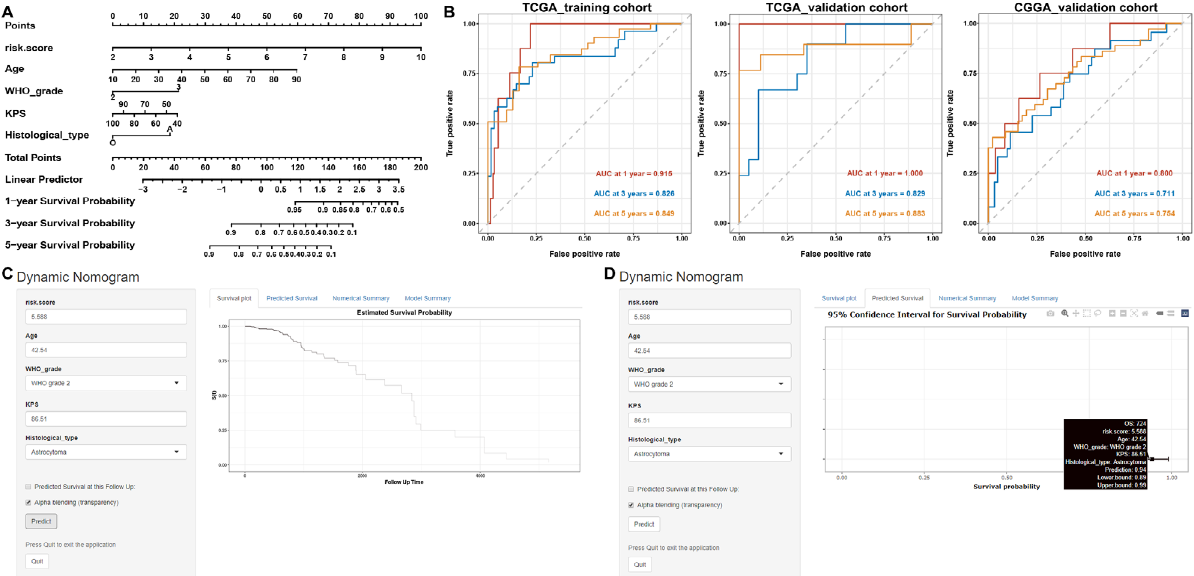
Figure 8. Construction and evaluation of a prognostic nomogram. (A) The nomogram predicts the probability of the 1-, 2-, and 3-year OS; (B) ROC curve of the nomogram predicts the probability of the 1-, 2-, and 3-year OS; (C, D) online dynamic nomogram accessible at